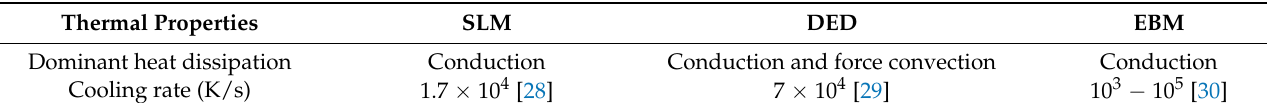
Table 2. Thermal behavior of different processes for Ti6Al4V.